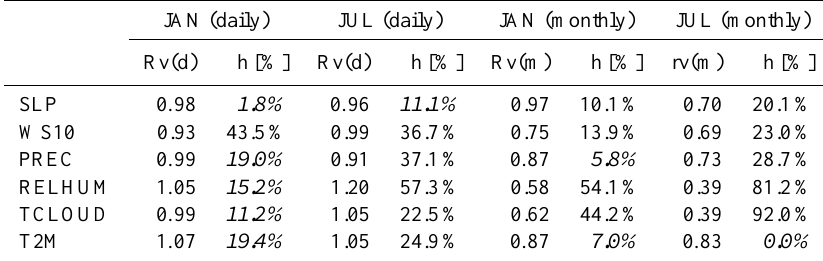
Table 2. Mean ratio of variance between HiResAFF and RCAO (RCAX for T2M) on daily (left) and monthly (right) scale for January and July. Additionally shown is the amount of local tests h [%] showing significant deviations of φ with p < 0 . 05. Values in italics show no field significance for the deviation in variance with p < 0 . 05.